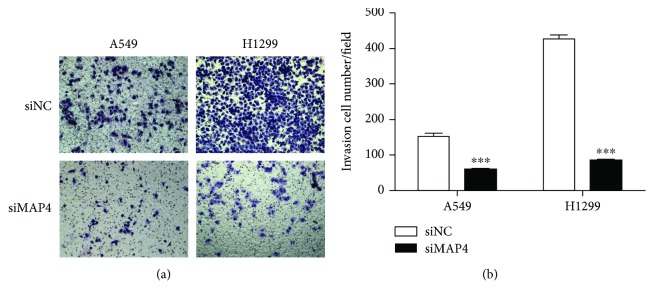
MAP4 promotes LADC cell invasion in vitro. The matrigel transwell assay was performed in A549 and H1299 cells transfected with MAP4 siRNA or a negative control to determine cell invasion potential. The number of cells migrated to the bottom were calculated manually. MAP4 knockdown repressed the cell invasion in both two types of cells. (a) Representative photos of invasive cells. (b) Quantification analysis of the invasive cell number per field. Data represent mean + SD of duplicates from three fields of view (∗∗∗P < 0.001, Student's t-test).